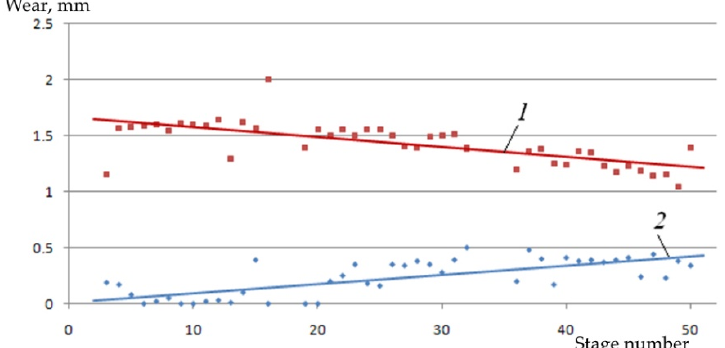
Figure 1. Change in wear of thrust washers of VNN5A-100 in relation to the grain size R of mechanical impurities: 1 — R = 800…1000 μ m; 2 — R = 20…30 μ m [9].